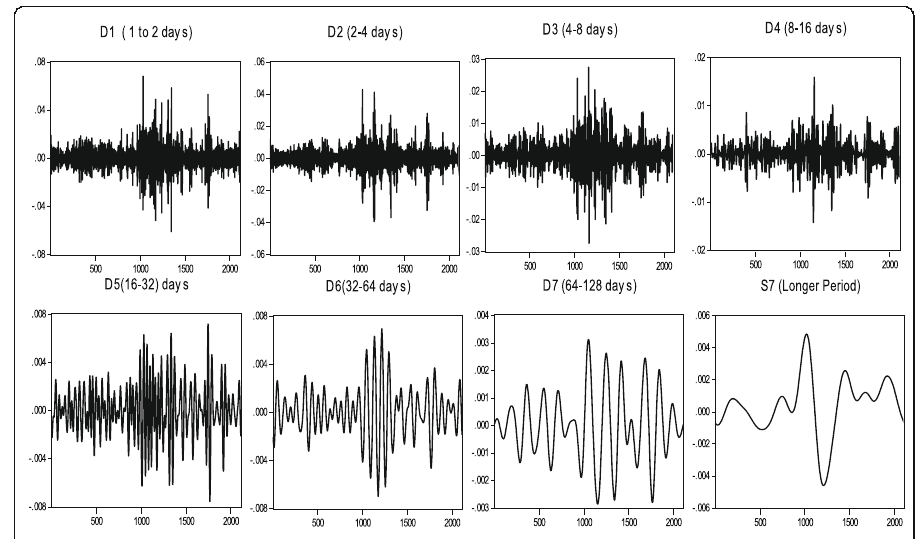
Fig. 3 Multi-scale decomposition of BSE-S&P 500 index